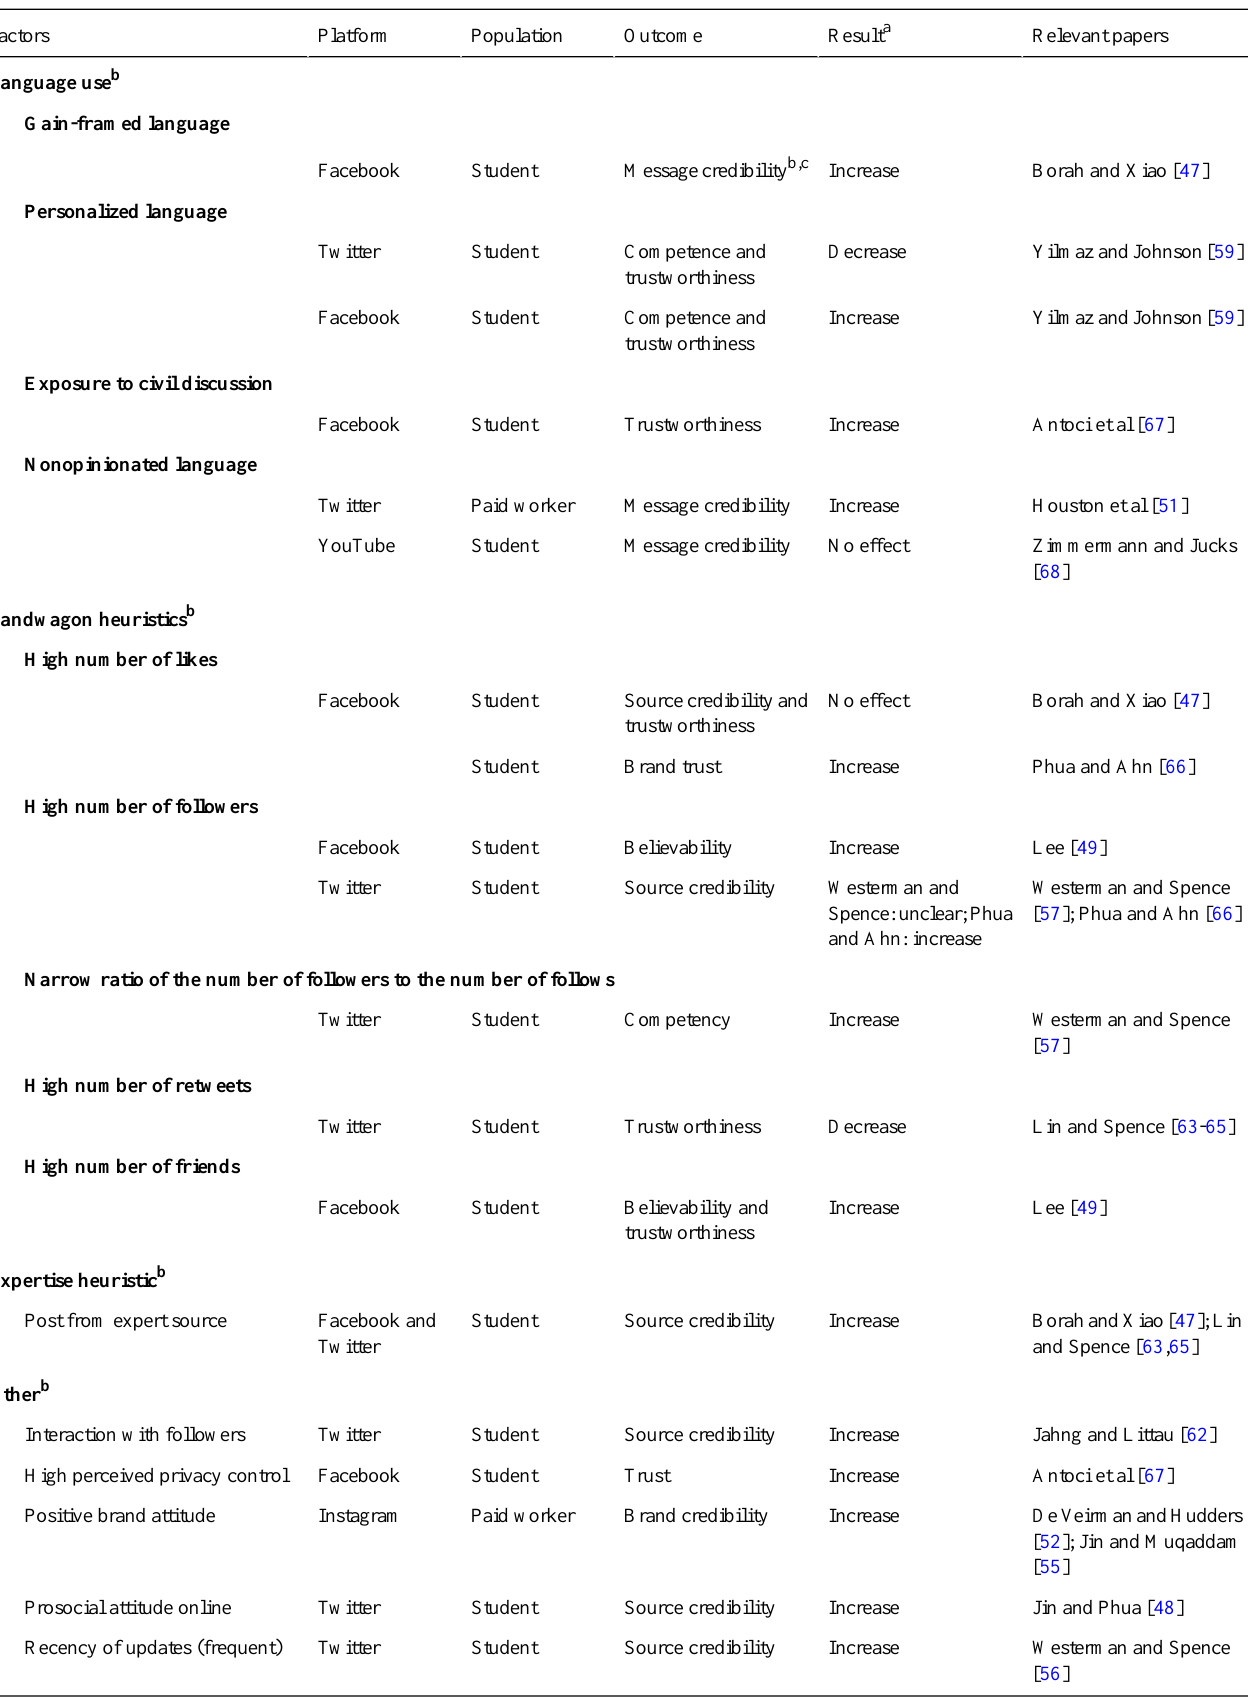
Table 2. Included papers, main outcomes, and the effect on either brand trust, message credibility, or source credibility (including trustworthiness, believability, and competence) as specified in their